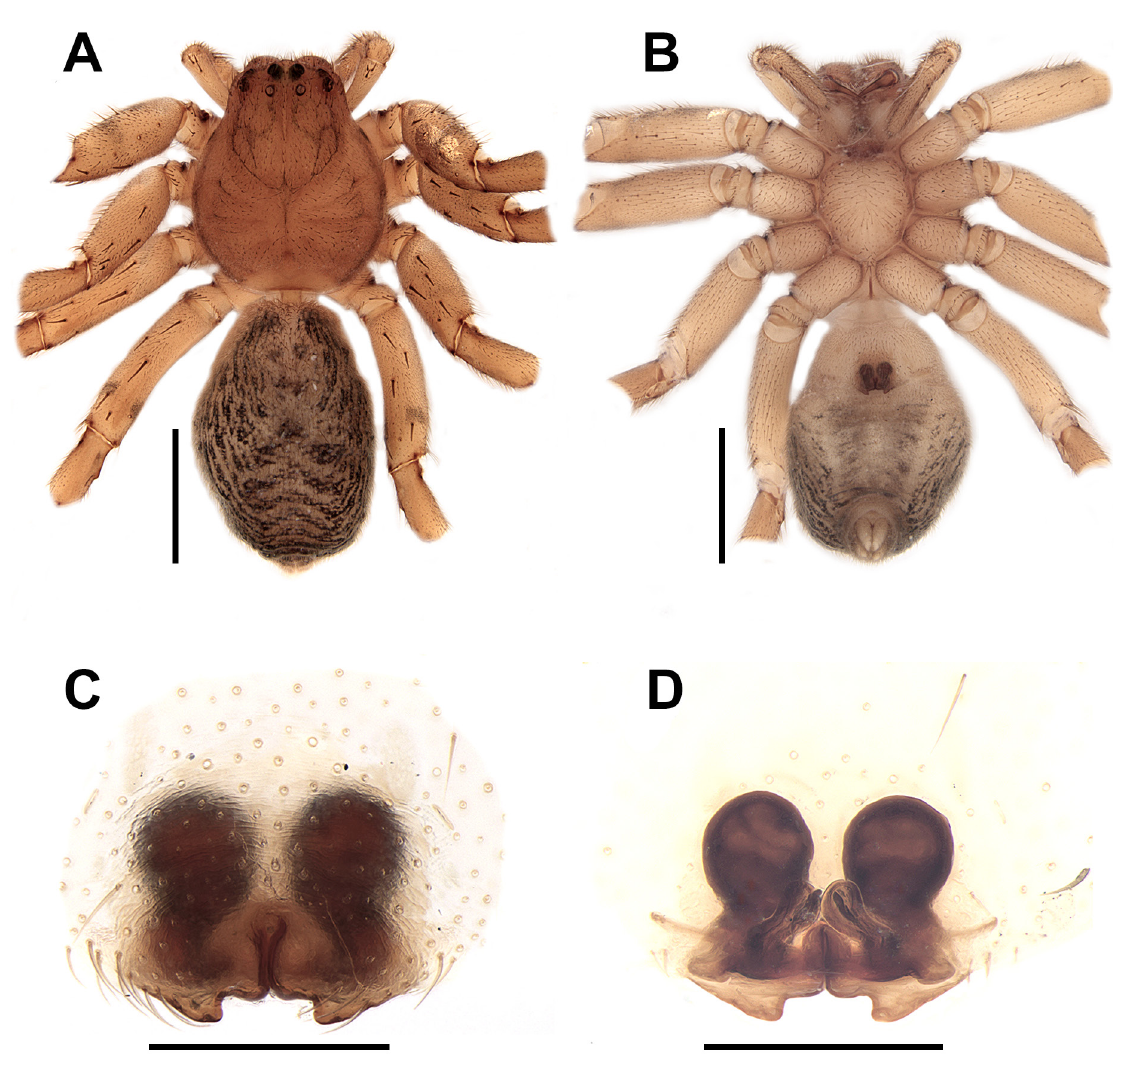
Fig. 9. Cuiambuca vacabrava sp. nov., paratype, ♀ (IBSP 43277). A . Habitus, dorsal view; B . Habitus, ventral view; C . Epigyne, ventral view. D . Vulva, dorsal view. Scale lines: A−B = 2.0 mm; C−D = 0.5